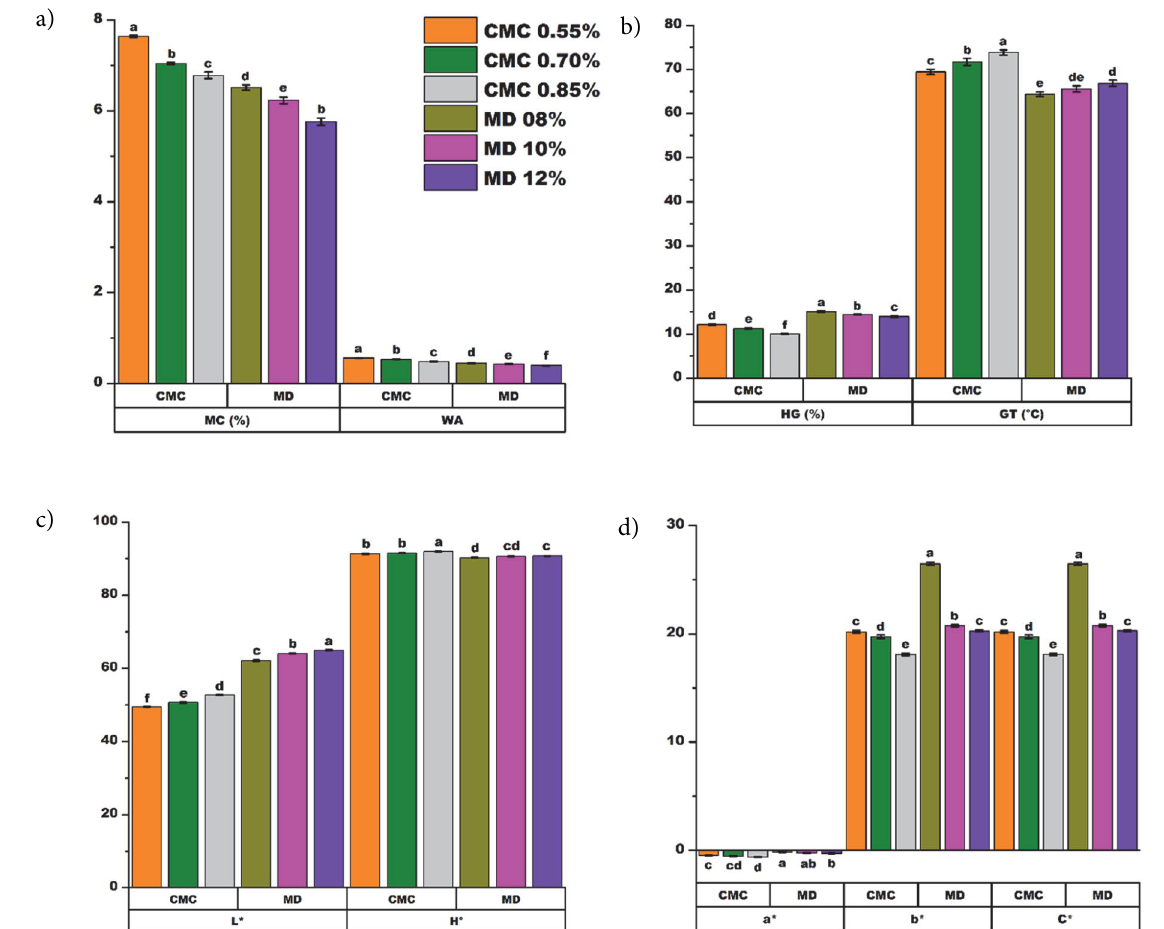
Figure 4: Effect of carriers on shelf-life and chromatic properties of encapsulated freeze-dried mulberry leaf extract powders MC-moisture content, WA-water activity, HG-hygroscopicity, GT-glass transition temperature, L*- lightness/darkness, a*- redness/greenness, b*- yel- lowness/blueness, C*- chroma, H°- Hue, CMC-sodium carboxymethyl cellulose, and